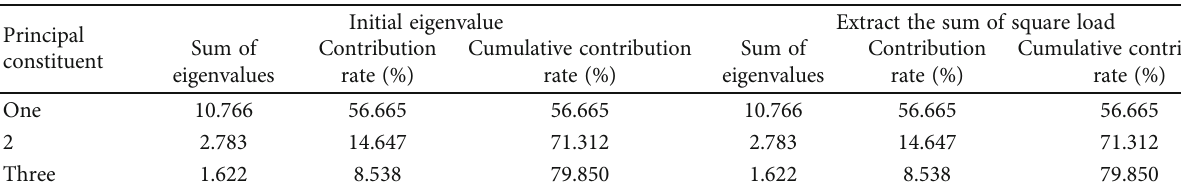
Figure 5: Time trend of digital industry progress subindex in A. Table 5: Eigenvalue and contribution rate.